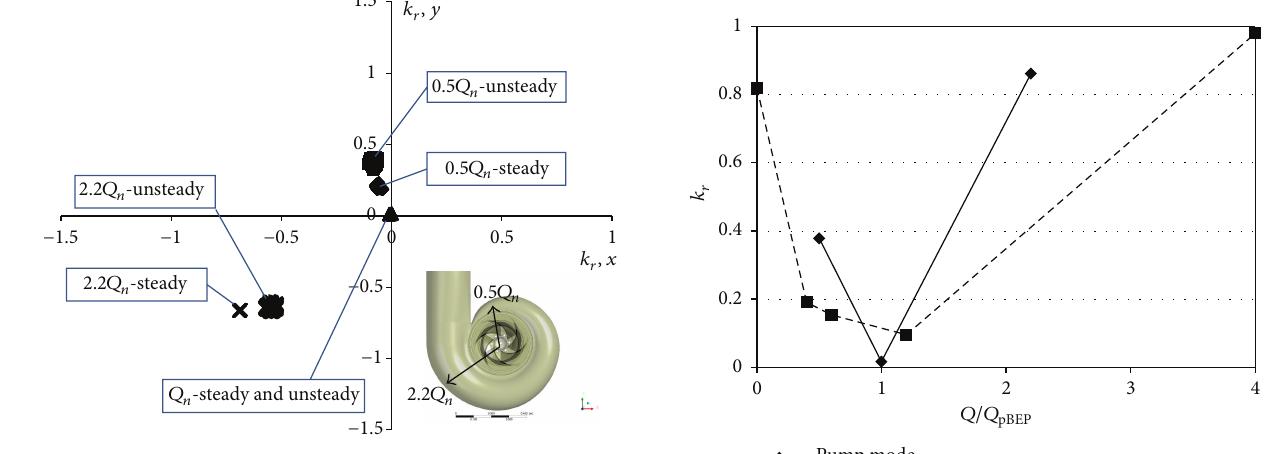
Figure 11: Components of radial thrust in pump mode 0.5 𝑄 𝑛 , 𝑄 𝑛, and 2.2 𝑄 𝑛 .